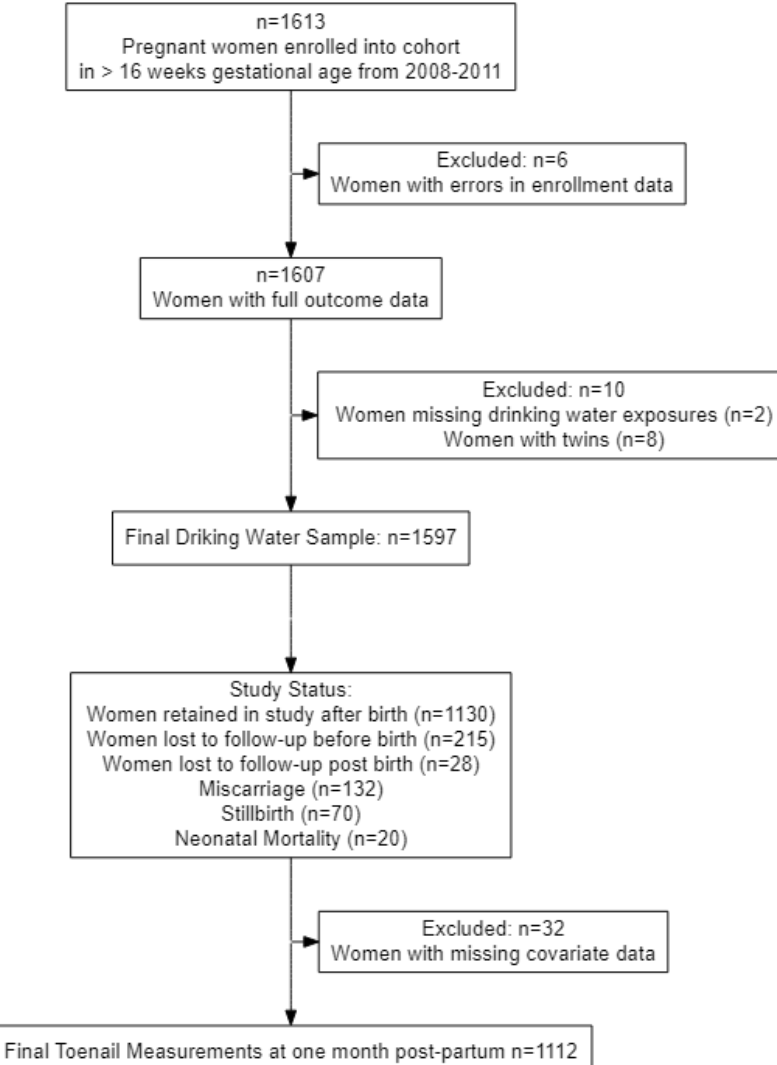
Figure 1. Study population for analysis. Table 1. Characteristics of Bangladesh Cohort by Adverse Pregnancy Outcome ( n = 1597).